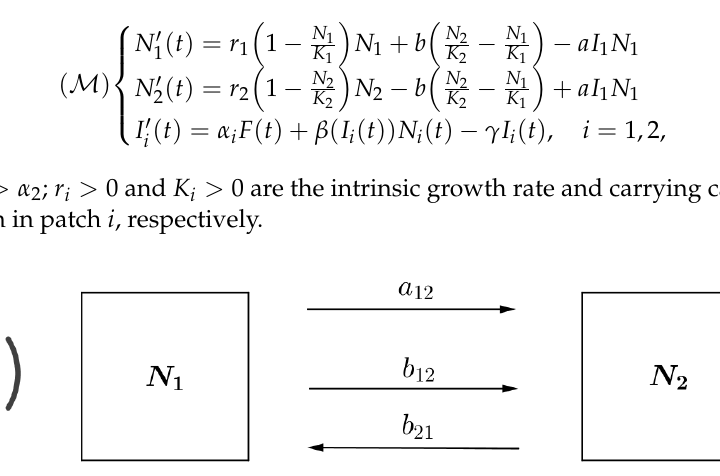
Figure 1. Diagram of two migration processes between patches. In order to avoid noise and occupied patches, individuals migrate by two processes: a uniderectional process where individuals migrate from patch 1 to patch 2 due to antropogenic noise with migration rate a 12 = aI 1 and a random process where individuals migrate between patches 1 and 2 in search of the patch with the lowest occupancy level with migration rates b 12 = b / K 1 and b 21 = b / K 2